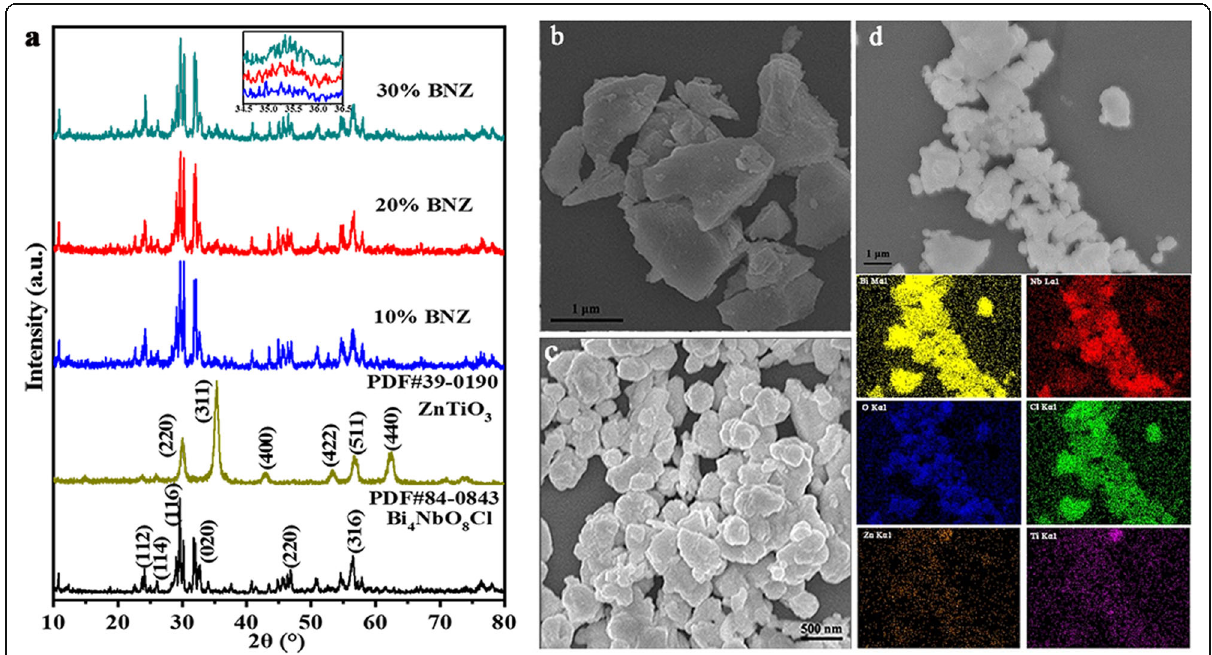
Fig. 1 a XRD patterns of ZnTiO 3 , Bi 4 NbO 8 Cl, and BNZ samples; SEM images of b Bi 4 NbO 8 Cl, c ZnTiO 3 , d SEM image, and EDX mapping images of 20%